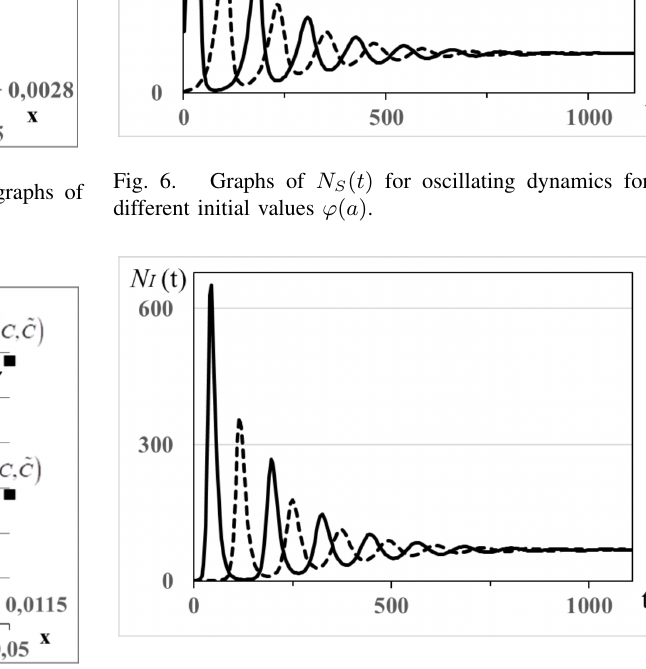
Fig. 7. Graphs of N I ( t ) for oscillating dynamics for 2 different initial values ϕ ( a )